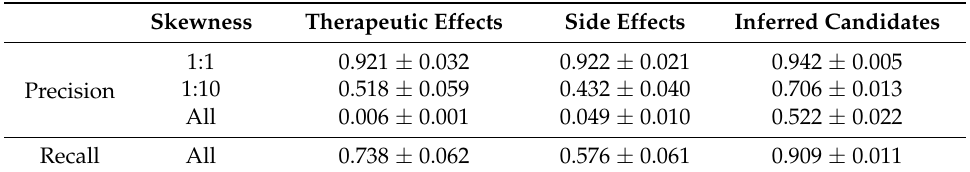
Table 3. Precision and recall performance of molecular network analysis in predicting therapeutic effects, side effects and potential candidate